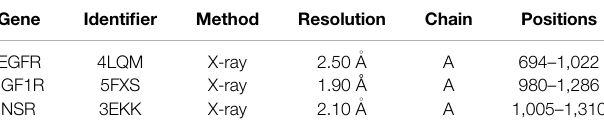
TABLE 1 | The protein crystal structure of key macromolecular